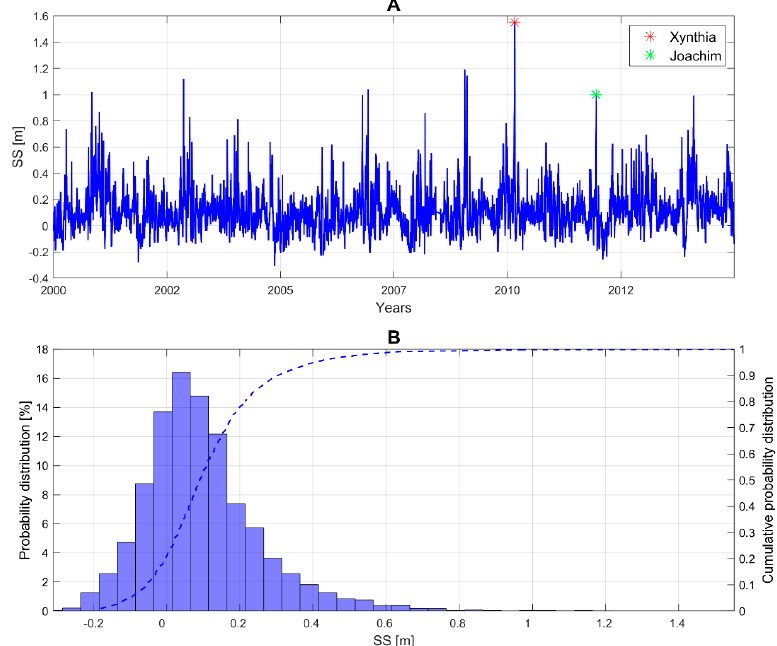
Figure 2. ( A ) Daily maximum storm surge (SS) time series at La Rochelle–La Pallice tidal gauge from 2000 to 2014 and the extreme events of Xynthia (February 2010) and Joachim (December 2011). ( B ) Descriptive probability distribution (bars) and cumulative probability of SS (dashed line).